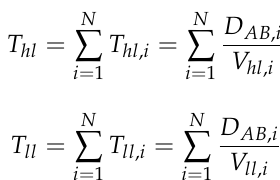
Figure 2. Illustration of a medium- and long-distance inland voyage.